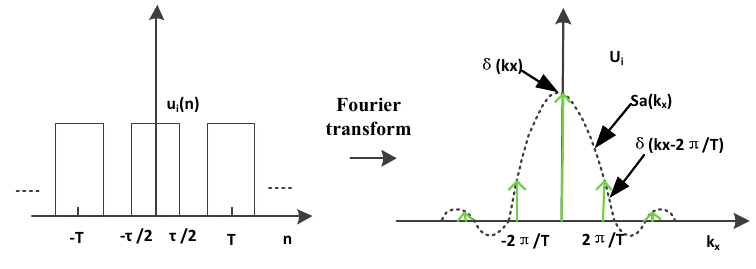
Figure 4. The Fourier transform of u i ( n ) .